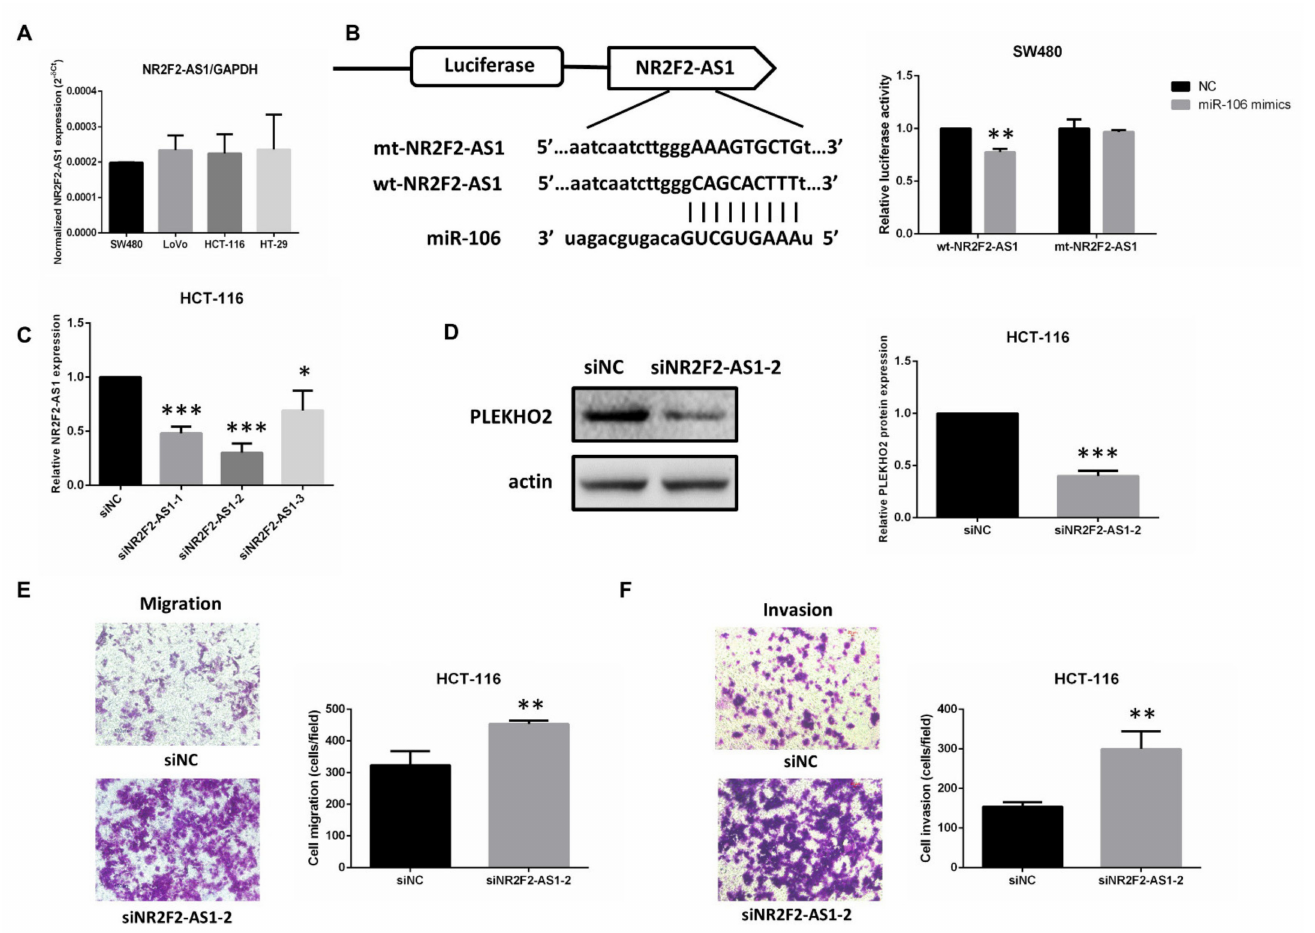
Figure 6. NR2F2-AS1 is a direct target of miR-106b. ( A ) The level of NR2F2-AS1 in 4 CRC cell lines was analyzed by qPCR. GAPDH served as an internal control. ( B ) Schematic illustration shows the miR-106b binding site and the reverse complementary sequence mutations in NR2F2-AS1. A luciferase activity assay was used to identify the miR-106b binding site. ( C ) Transfection efficiency of NR2F2-AS1 siRNA in HCT-116 cells was analyzed by qPCR. ( D ) The protein expression of PLEKHO2 is decreased by transfection of NR2F2-AS1 siRNA. ( E , F ) Transwell assay showed that the inhibition of NR2F2-AS1 in HCT-116 cells promotes both migration and invasion compared with the negative control. All data are shown as the mean ± SD ( n = 3), * p < 0.05, ** p < 0.01, *** p <